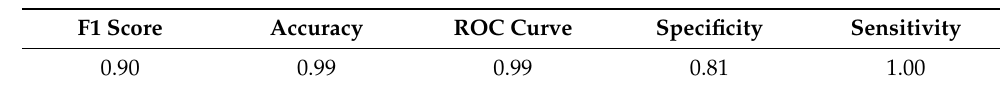
Figure 12. Possible Number of Clusters. Table 6. K-means experimental result.